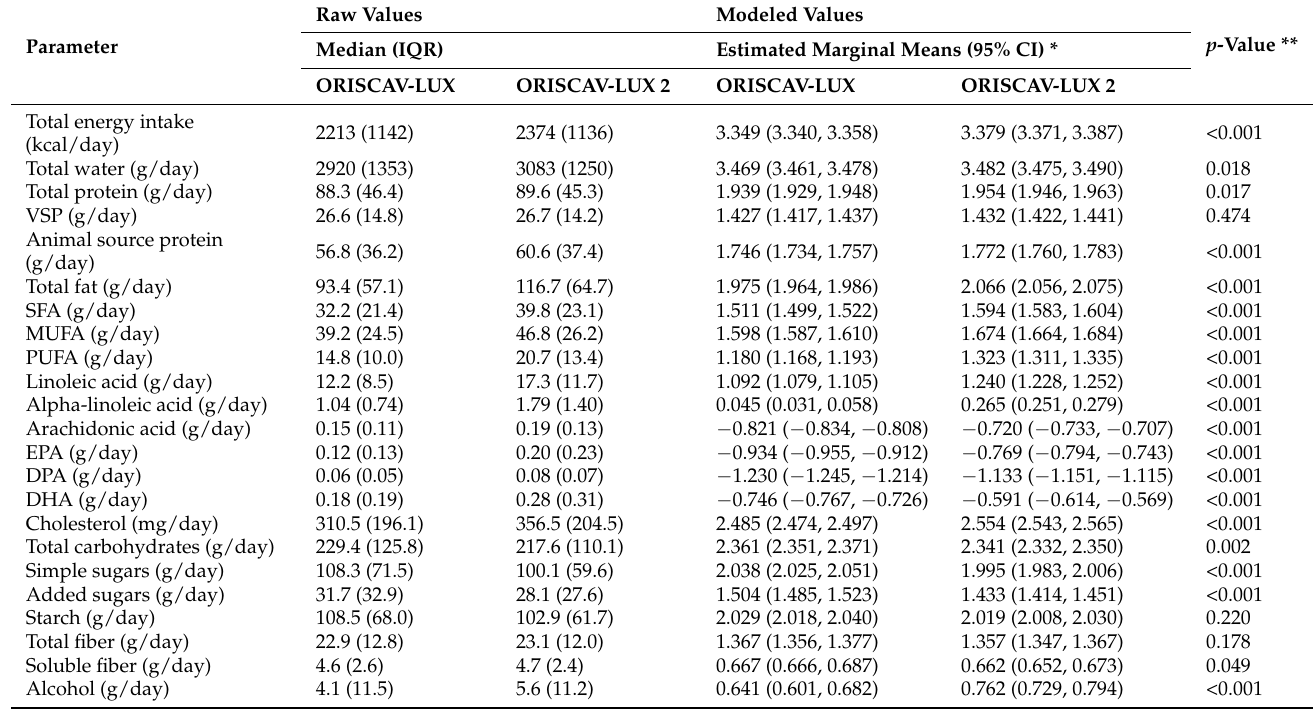
* Linear mixed model (based on log-transformed data) adjusted for age, gender, marital status, education, job, income, number of persons living in the same household. ** Benjamini–Hochberg correction was applied to all p -values: all p -values are displayed after